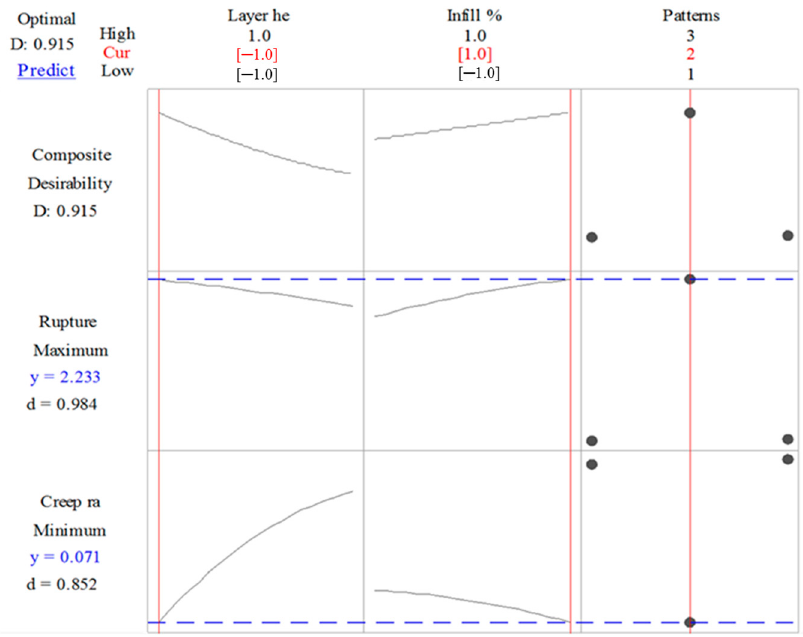
Figure 8. Multi ‐ response optimization plot obtained for creep phenomenon using Minitab software. Figure 8. Multi-response optimization plot obtained for creep phenomenon using Minitab